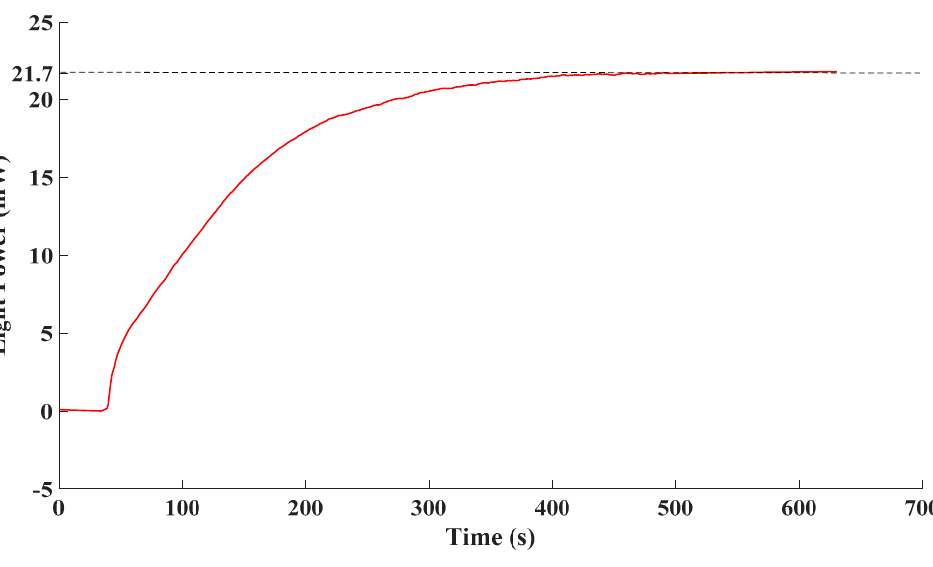
Figure 8. Output of the excimer lamp.